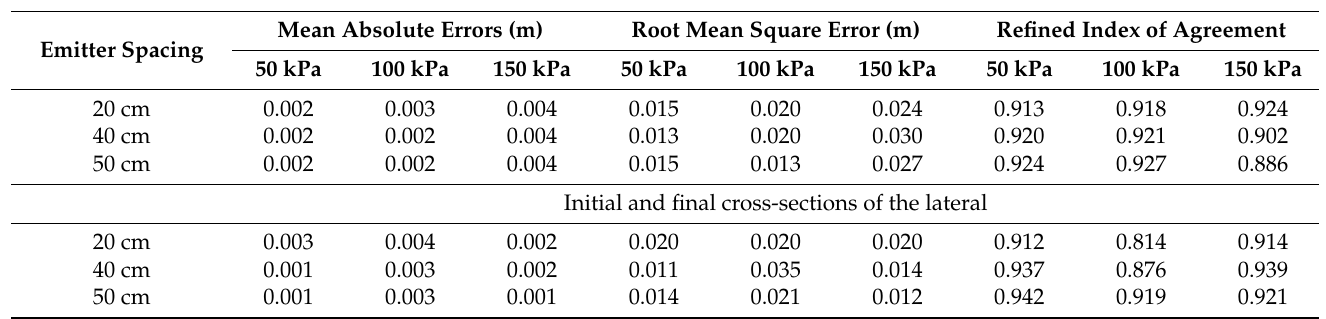
Table 4. Mean absolute errors ( MAE ), the root mean square error ( RMSE ), and the refined index of agreement ( dr ) indices obtained when comparing the observed and predicted wetted areas in the longitudinal and transversal flow